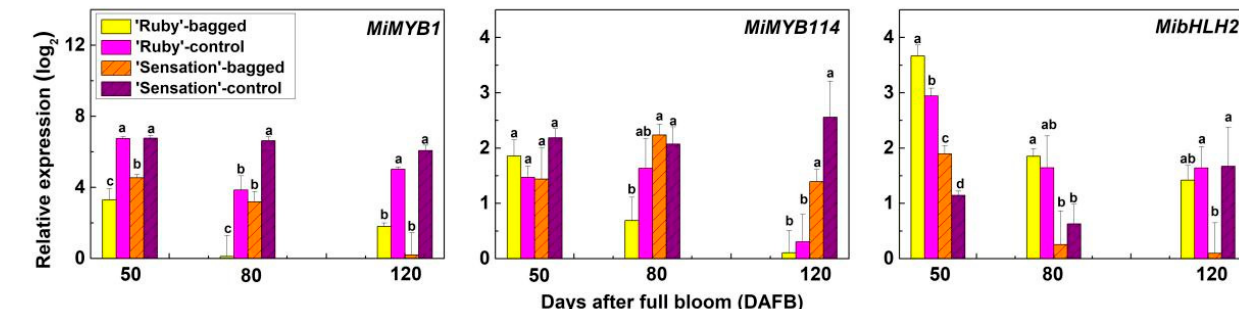
Figure 4. log 2 expression levels of anthocyanin regulatory genes in bagged and control (non-bagged) ‘Ruby’ and ‘Sensation’ mango fruit skin at different developmental stages. Each value represents the mean ± standard deviation of three biological replicates. Mean values were compared within the same day after full bloom, and values with the same letter are not significant-ly different, p > 0.05 according to Tukey tests.